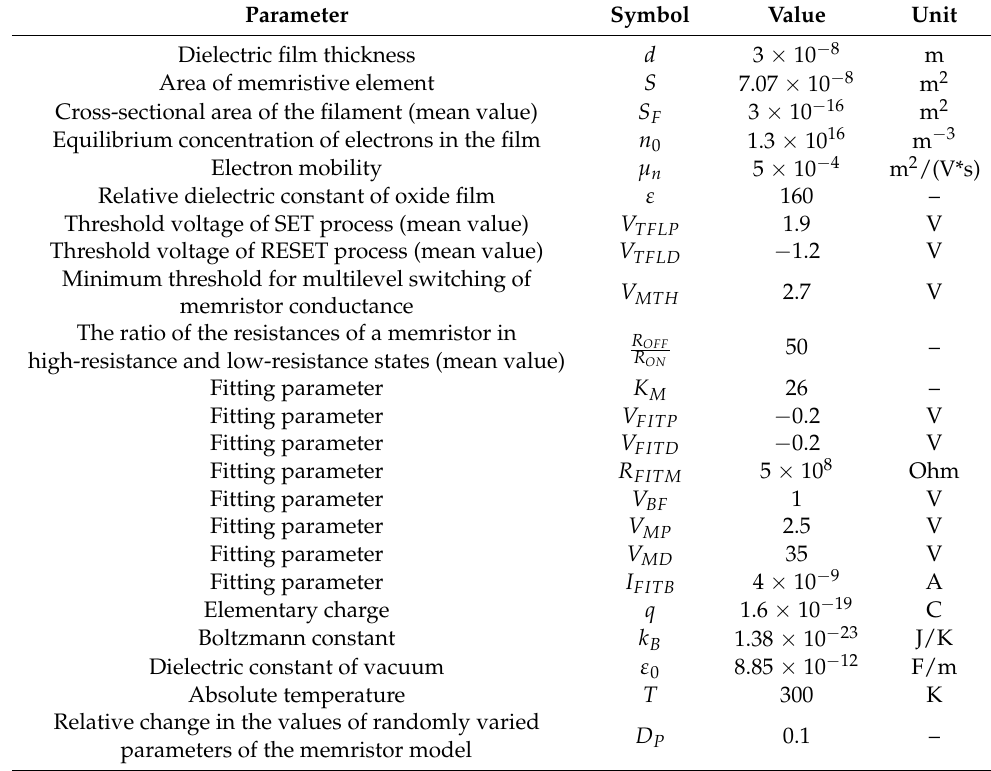
Table 1. Model parameters for a memristor with the structure shown in Figure 2a. Parameter Symbol Value Unit Dielectric film thickness d Area of memristive element S Cross-sectional area of the filament (mean value) S F 3 × 10 − 16 Equilibrium concentration of electrons in the film n 0 Electron mobility Relative dielectric constant of oxide film Threshold voltage of SET process (mean value) Threshold voltage of RESET process (mean value) Minimum threshold for multilevel switching of memristor conductance The ratio of the resistances of a memristor in R OFF R ON high-resistance and low-resistance states (mean value) Fitting